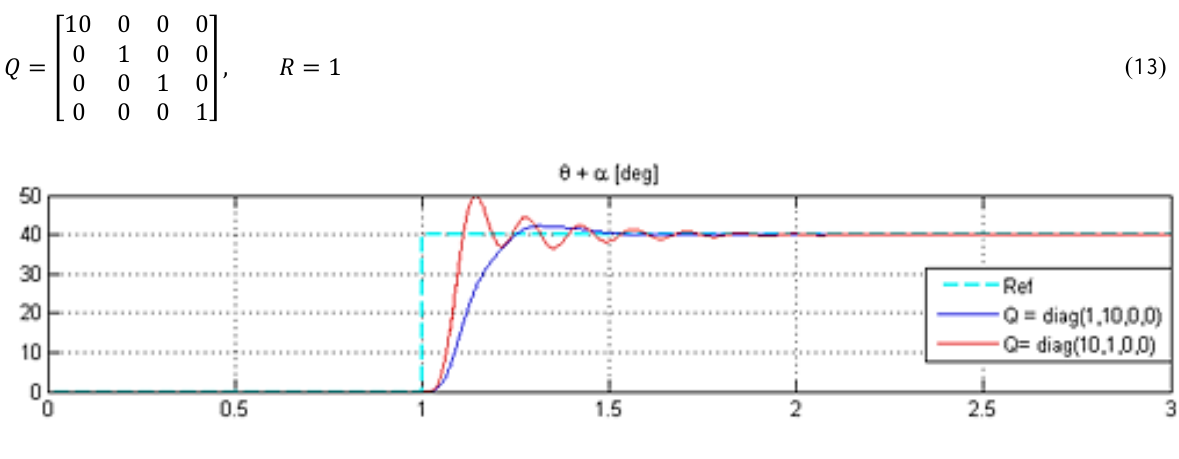
Figure 4. Time response of the closed-loop system with DLQR controller and different